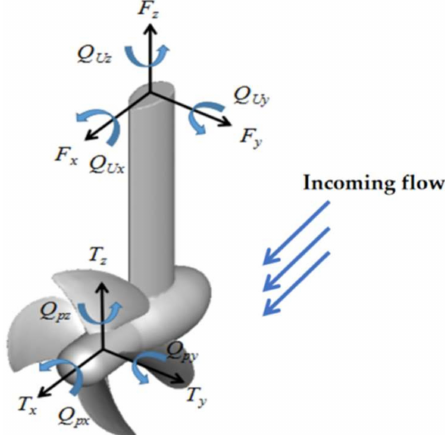
Figure 6. Schematic of forces acting on the pod unit.